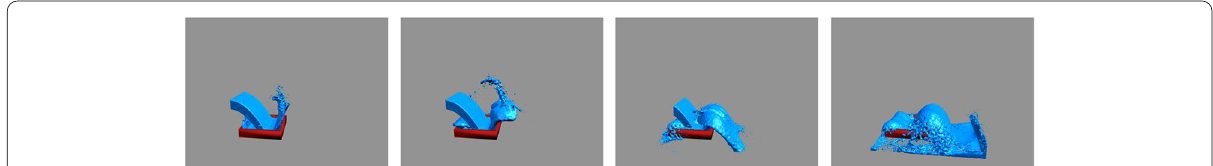
Fig. 7 Visual simulation of a fluid pouring into a water tank and gradually filling a container, using the VSLSPH method (10000 particles)